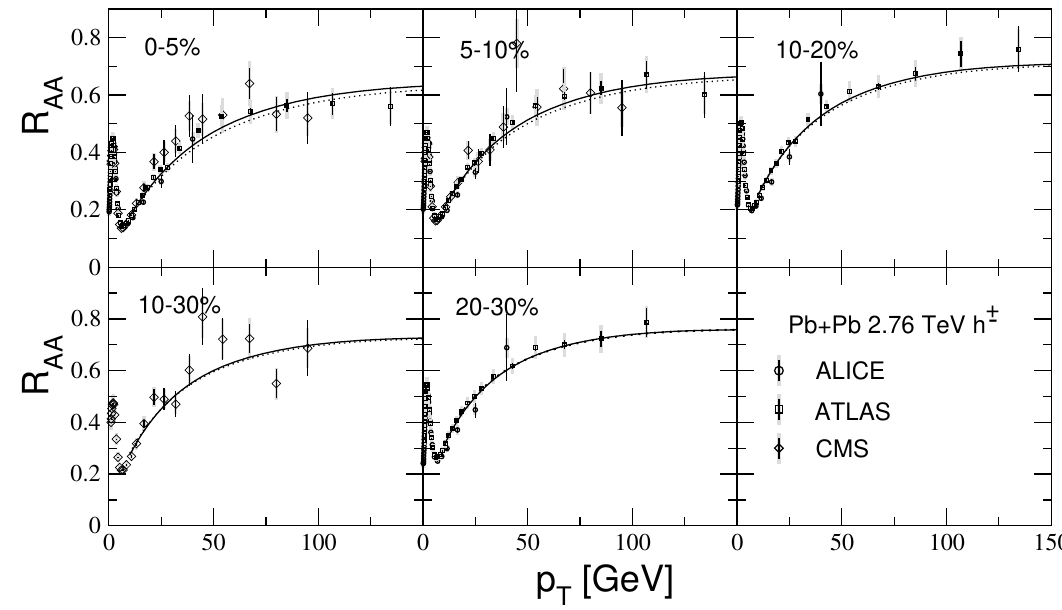
Figure 4 . R AA of charged hadrons for 2 . 76 TeV Pb+Pb collisions from our calculations with k = 2 , c = 0 . 8 , τ 0 = 0 . 5 fm for scenarios without (solid) and with (dotted) mQGP formation in pp collisions for the optimal parameters κ = 3 . 44 and 2 . 57 obtained by fitting R AA in the range 10 < p T < 120 GeV. Data points are from ALICE [75], ATLAS [76], and CMS [77].